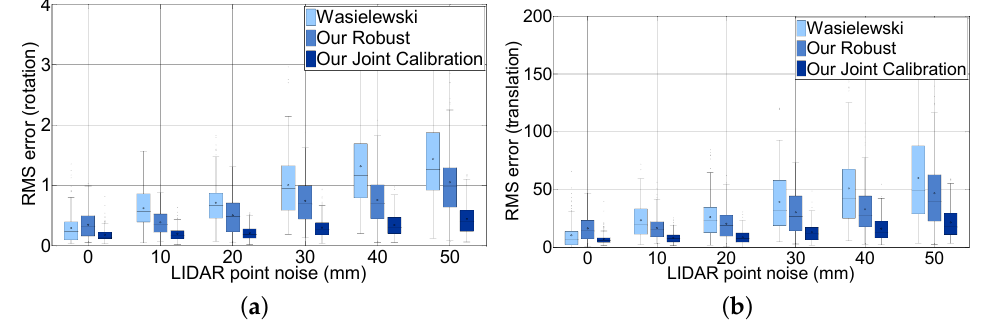
Figure 12. Effect of the LiDAR distance noise using synthetic data: ( a ) RMS error of rotation in degrees and ( b ) RMS error of translation in millimeters; RMS error increases proportional to the LiDAR scan